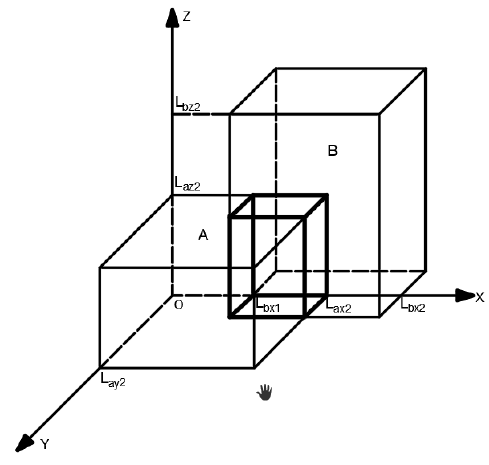
Figure 10. Three-dimensional sketch of AABB bounding box.